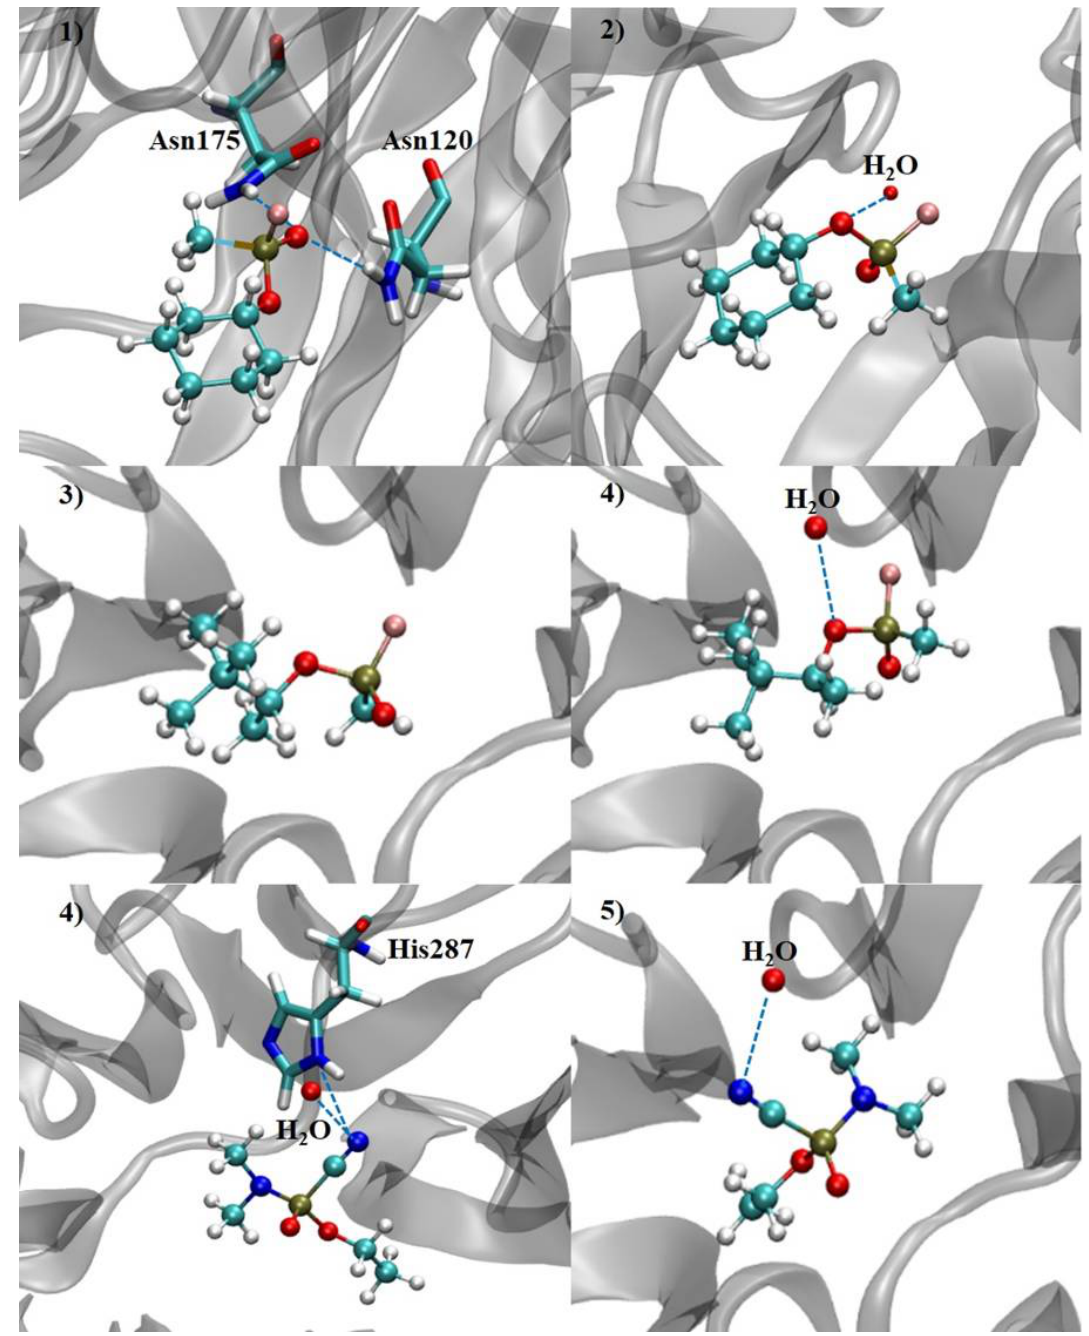
Figure 11. Hydrogen bonds performed by the nerve agents in the DFPase active site (Cyclosarin: R P ( 1 ) and S P ( 2 ) enantiomers; Soman: R P ( 3 ) and S P ( 4 ) stereoisomers; Tabun: R P ( 5 ) and S P ( 6 ) enantiomers).